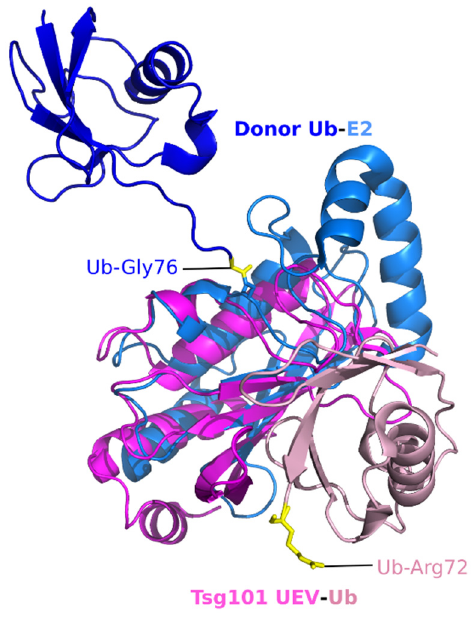
Figure 2. Superimposition of the h Tsg101 UEV domain complexed to Ub and canonical E2 (UbcH5) complexed to Ub. Tsg101 is dark pink, the complexed Ub is a light pink; E2 is light blue, the complexed Ub molecule is dark blue. UEV-Ub, PDB ID: 1S1Q [32]; E2-E3-Ub (E3 not shown), PDB ID: 3JVZ [34]. The donor Ub Gly76 residue thioesterified to the E2 is yellow. The C-terminus of the Ub moiety partnered with the UEV is flexible and therefore not apparent in the crystal structure. The last ‘rigid’ residue, R72, is highlighted to give the reader an idea of where the C-terminus lies. The E2 active site Cys residue replaced with Tyr in the Tsg101 sequence is replaced with Asp in the UEV h Mms2 [39,40]. Its Ub-binding affinity (100 µ M, [41]) is greater than that determined for Tsg101 UEV Ub binding (~500 µ M). An overlay of the human